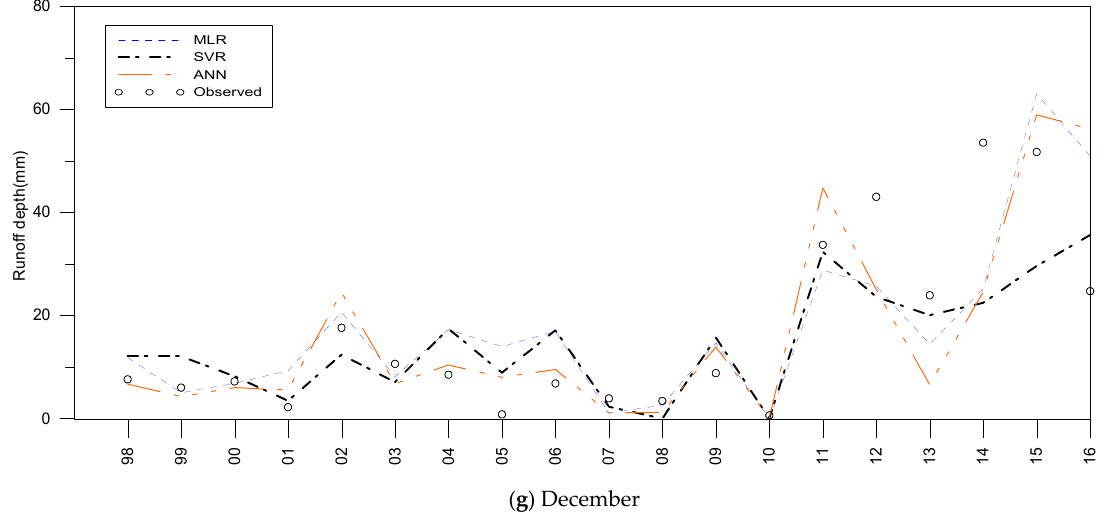
Figure 6. Comparison of the observed (dot shape) and predicted (dashed line) reservoir inflow from three models for January ( a ), February ( b ), March ( c ), April ( d ), May ( e ), November ( f ) and December ( g ) of years 1998–2016.